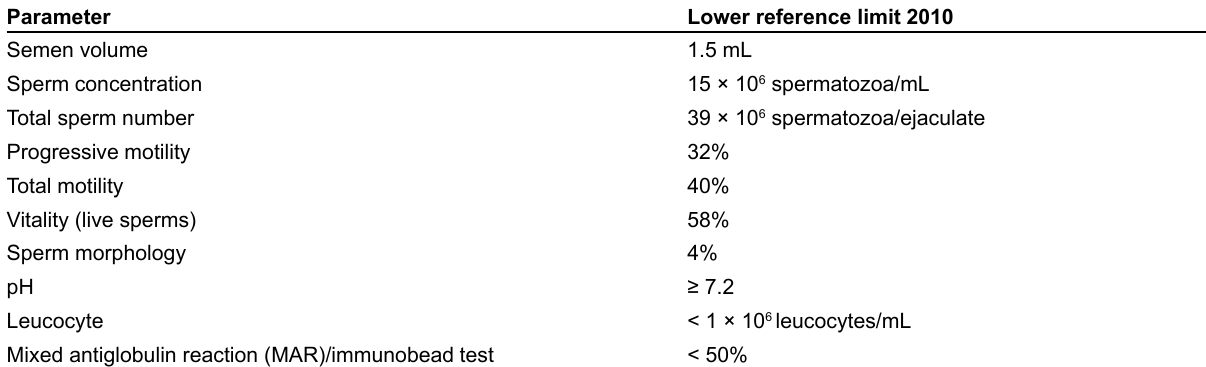
Table 2. Distribution of characteristics in the study population